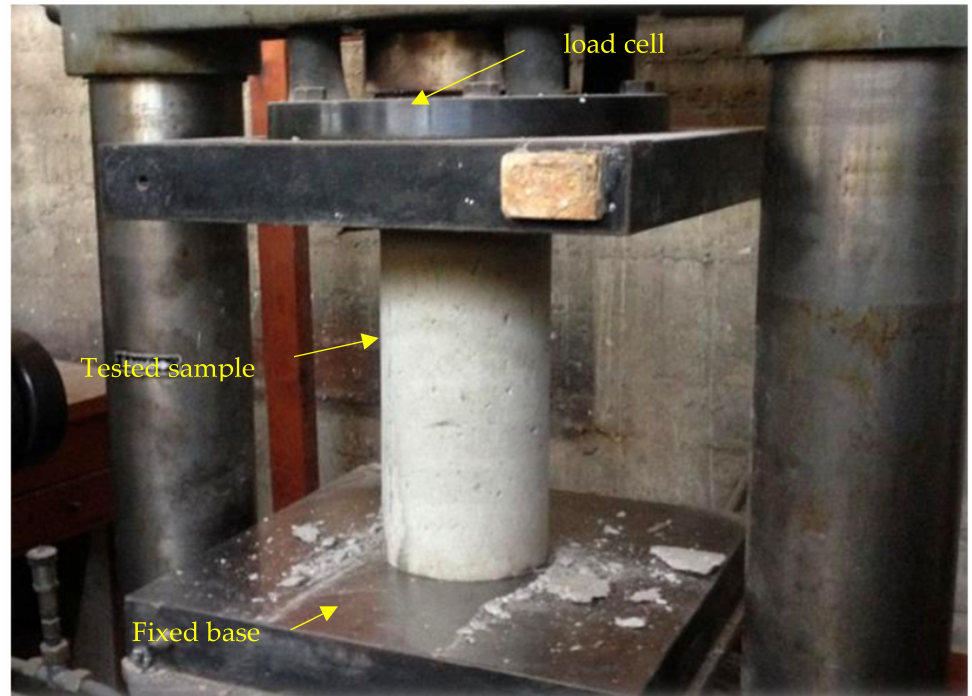
Figure 2. Experimental setup of compression test of representative concrete cylindrical sample of the test